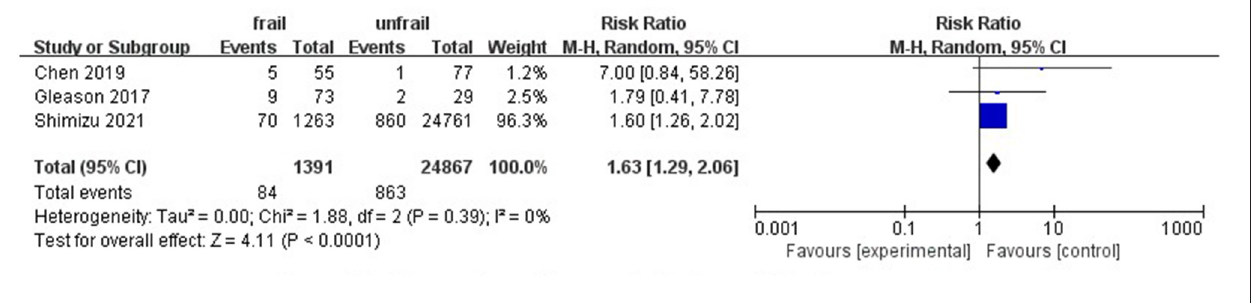
FIGURE 4 | Forest plots of frailty and 30-day readmission of hip